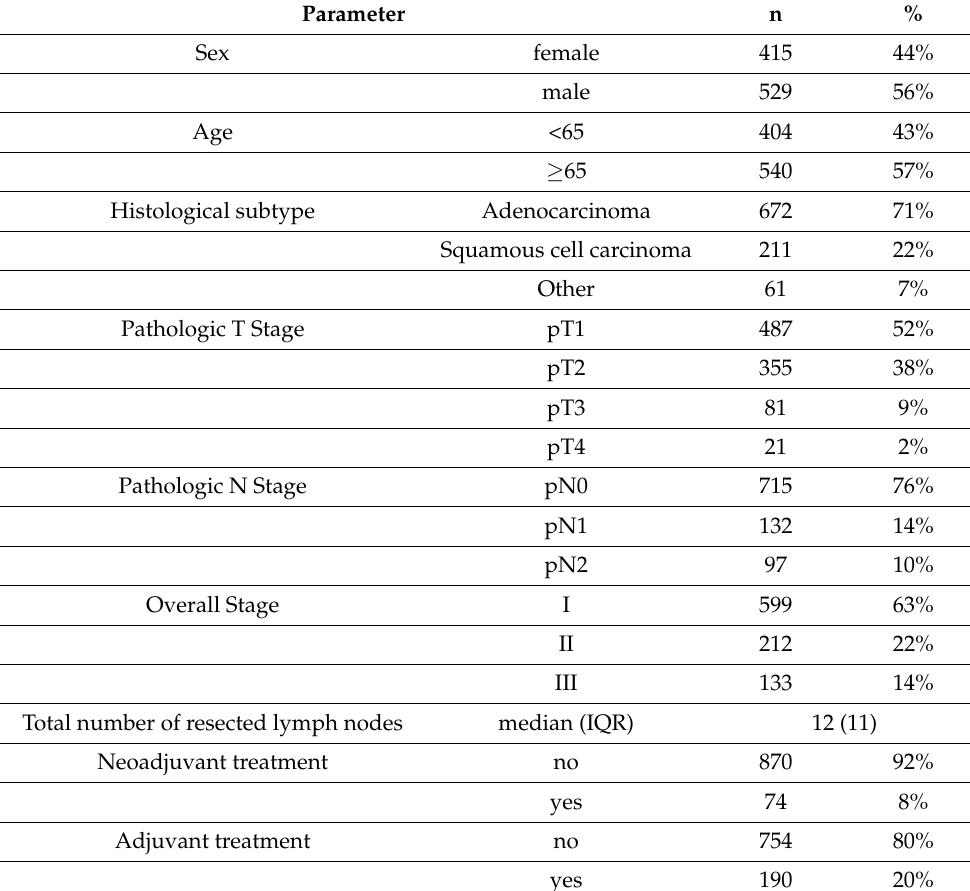
Table 1. Basic clinical and pathological parameters of 944 patients undergoing curative intent lobectomy for stage I-III